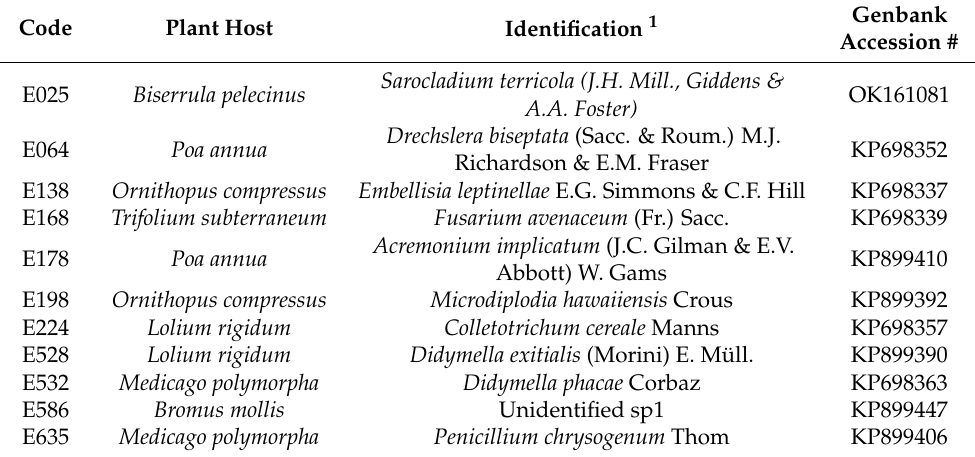
Table 1. Fungal endophytes used in the experiments. For every strain, the internal code used in the laboratory, the plant host where it was isolated from, the tentative identification, and the Genbank accession number are